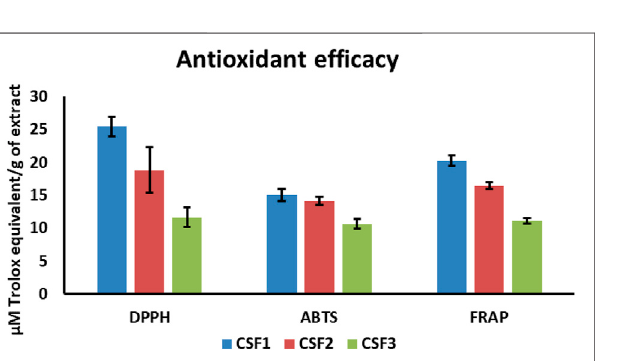
FIGURE 7 | Among all the supercritical CO 2 extracts of Cordyceps sinensis , CSF1 was discerned to have the highest in vitro free radical (DPPH, ABTS) scavenging activity and ferric ion reducing power (FRAP). Values are represented as mean ± SD ( n (cid:1) 3).